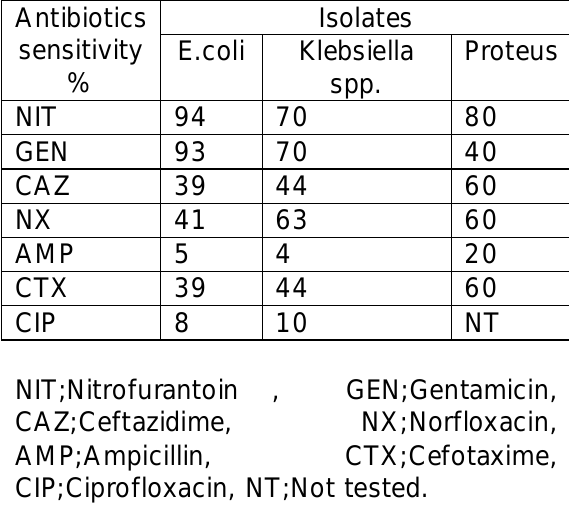
Table 4: Antibiotic Sensitivity Pattern Of E.Coli, Klebsiella spp. & Proteus.